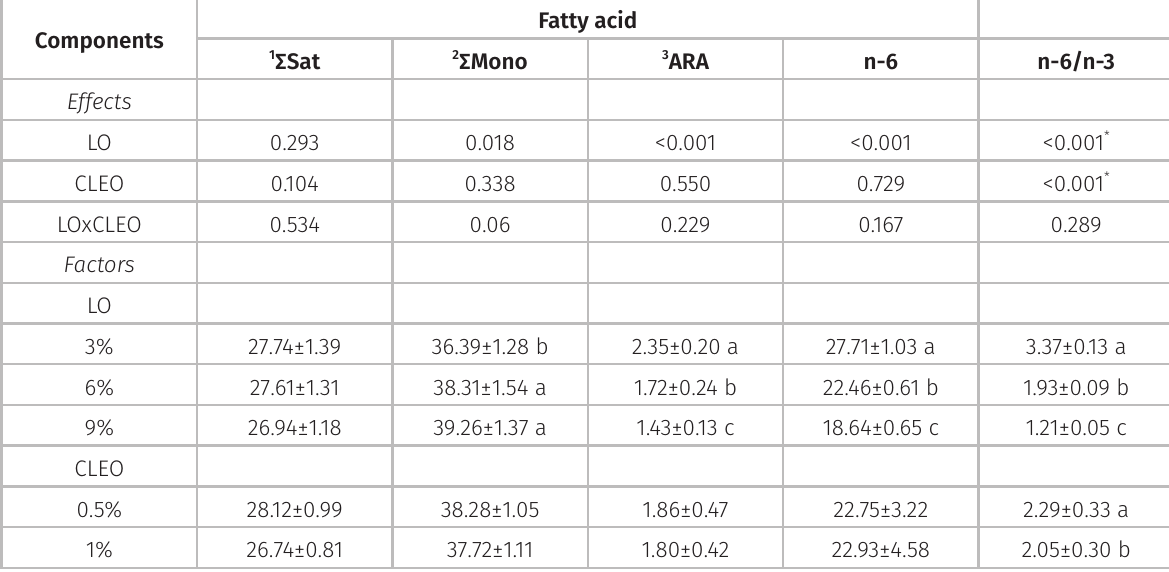
Table IV. Isolated effect on the fatty acid profile (% of the total) in the muscle of zebrafish ( Danio rerio ) fed diets containing linseed oil (LO) and clove leaf essential oil